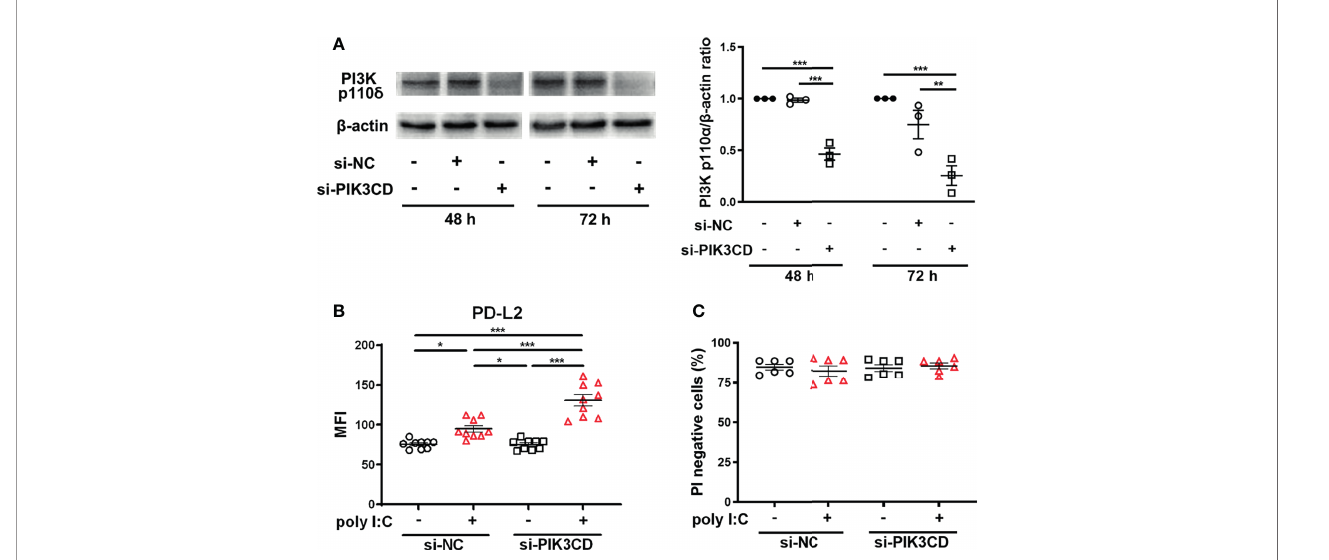
FIGURE 4 | siRNA knockdown of PIK3CD enhances poly I:C – induced upregulation of PD-L2 expression on PBECs. (A) Representative western blots showing PI3K p110 d in PBECs transfected with 10 nM PIK3CD siRNA or 10 nM negative control (NC) siRNA for 48 h or 72 h. Band intensity was quantitated using densitometry. Data represent means ± SEM (n=3 per group) of two replicates from two independent donors. (B, C) PBECs were transfected with 10 nM PIK3CD siRNA or 10 nM NC siRNA for 48 h and then stimulated with 1 m g/mL poly I:C or vehicle for 24 h. PD-L2 expression or PI-negative viable cells were analyzed using fl ow cytometry. Data represent means ± SEM (n=6 – 9 per group) were pooled from a minimum of two independent donors with three replicates. * p <0.05, ** p <0.01, *** p <0.001 by one- or two-way ANOVA as appropriate. MFI, mean fl uorescence